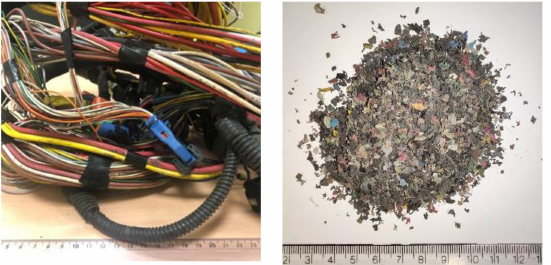
Figure 2. Automotive shredder residue (ASR) plastic sample before and after the grinding